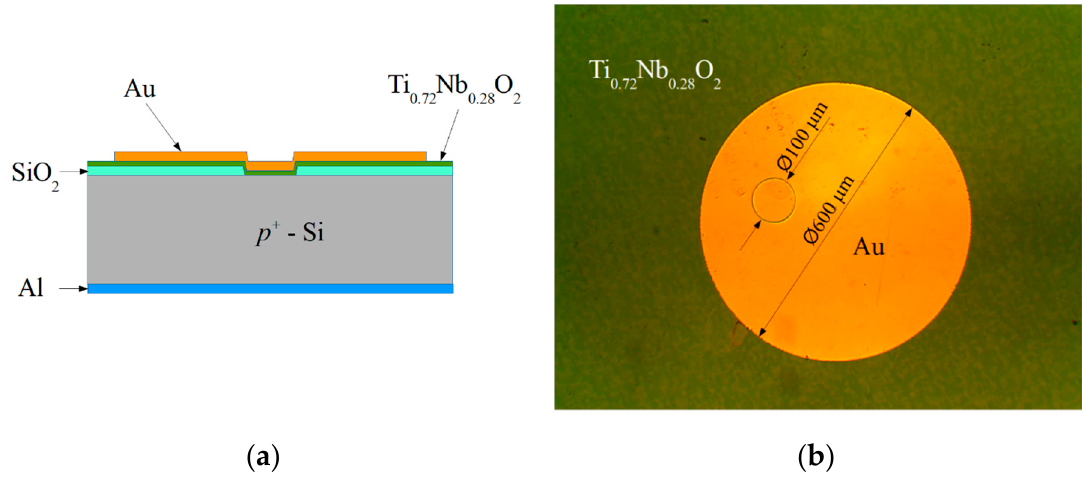
Figure 1. ( a ) Schematic cross-section of the TiO 2 / p -Si heterojunction device. ( b ) Microphotograph top view of TiO 2 / p -Si ( ∅ 100 µ m) and Au / TiO 2 ( ∅ 600 µ m) contacts ( b ).